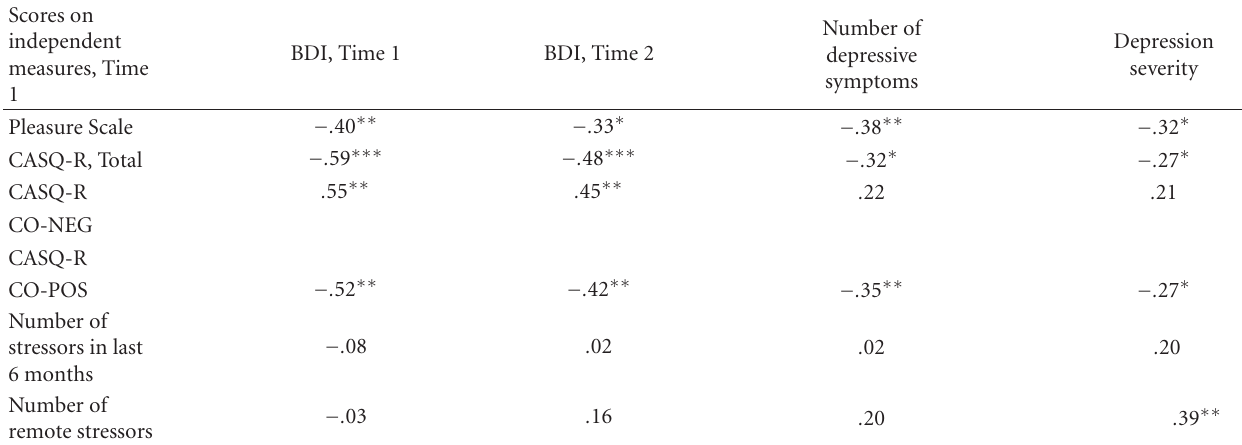
Table 2: Correlation coe ffi cient between